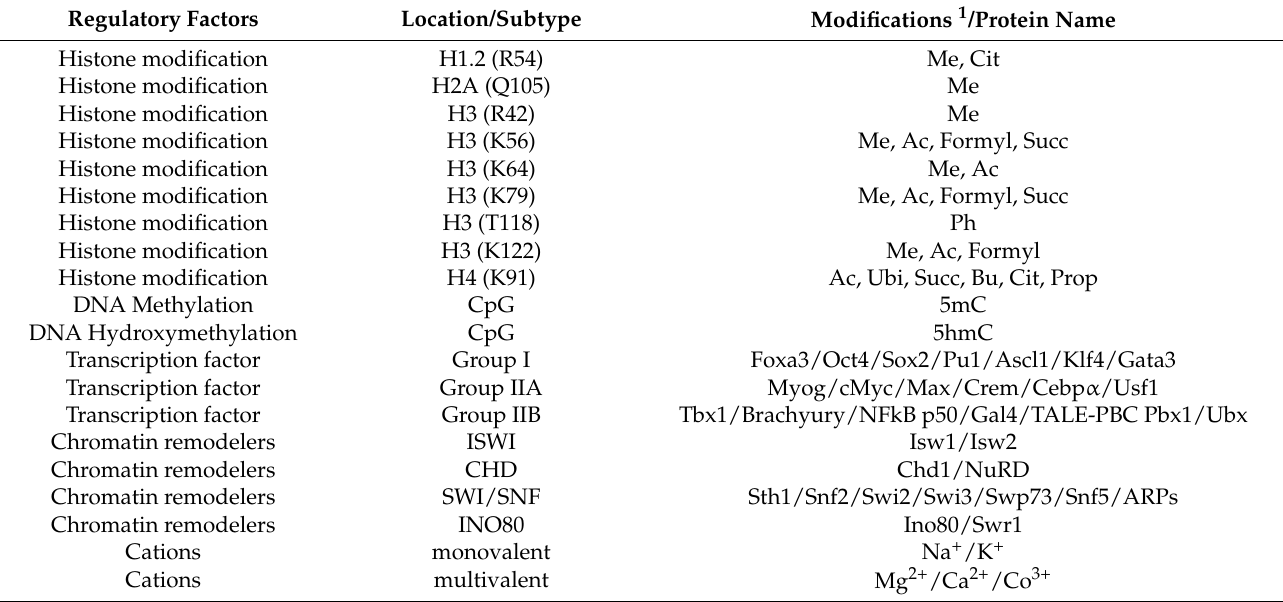
Table 1. Overview of the current, discovered regulatory factors of nucleosome